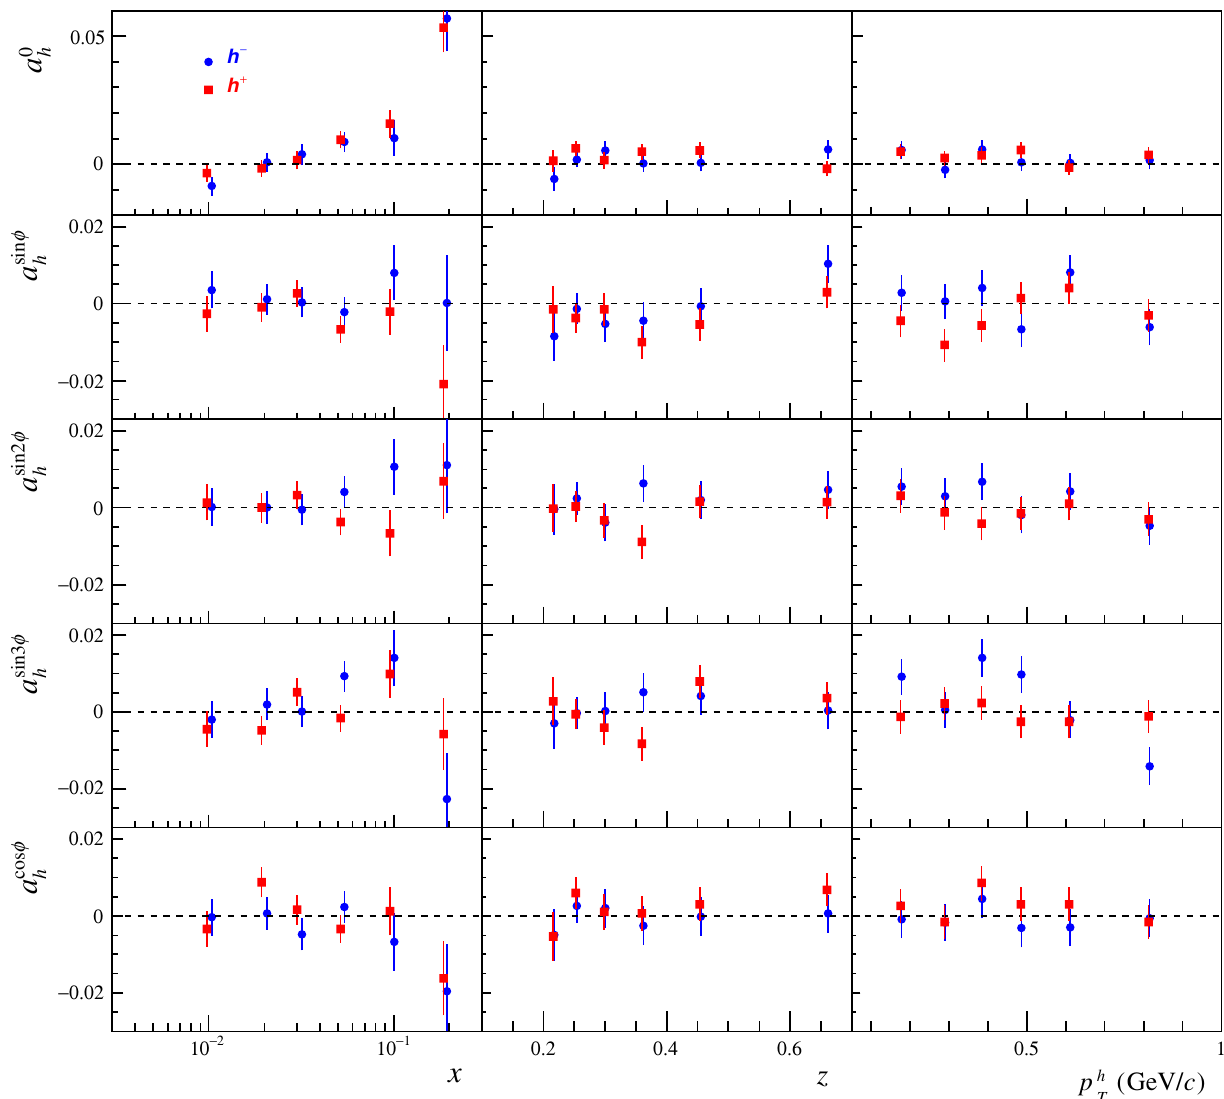
obtained from the combined T